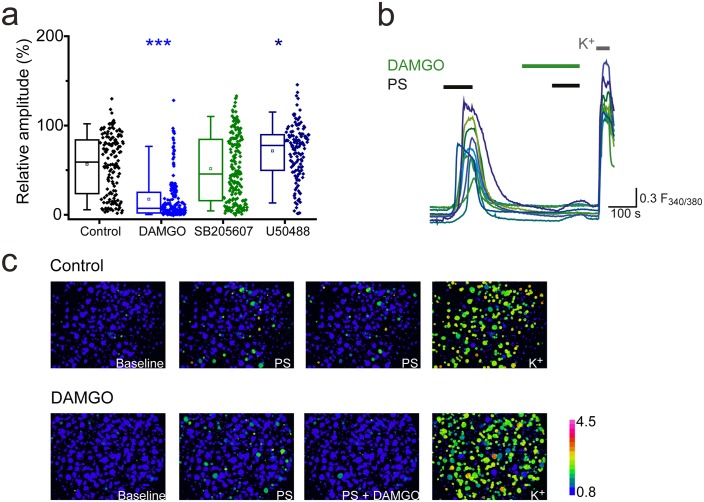
Activation of μ-opioid receptors inhibits TRPM3.(a) Effect of the selective μ opioid receptor agonist DAMGO, δ opioid receptor agonist SB205607 and κ opioid receptor agonist U50488 (each at 20 nM) on [Ca2+]i-responses evoked by PS (20 µM, second application, see Figure 1 for protocol). *p<0.05, ***p<0.001; Kruskal-Wallis (control, n = 152; DAMGO, n = 184; SB205607, n = 200; U50488, n = 140). (b) Traces displaying the effect of DAMGO (20 nM) on neuronal [Ca2+]i responses to stimulation with PS (20 µM). F(340/380) indicates fura-2 emission ratio. (c) Pseudocolour images illustrating the change in F340/380 ratio in response to PS and KCl with the colours corresponding to various F340/380 values indicated by the bar.